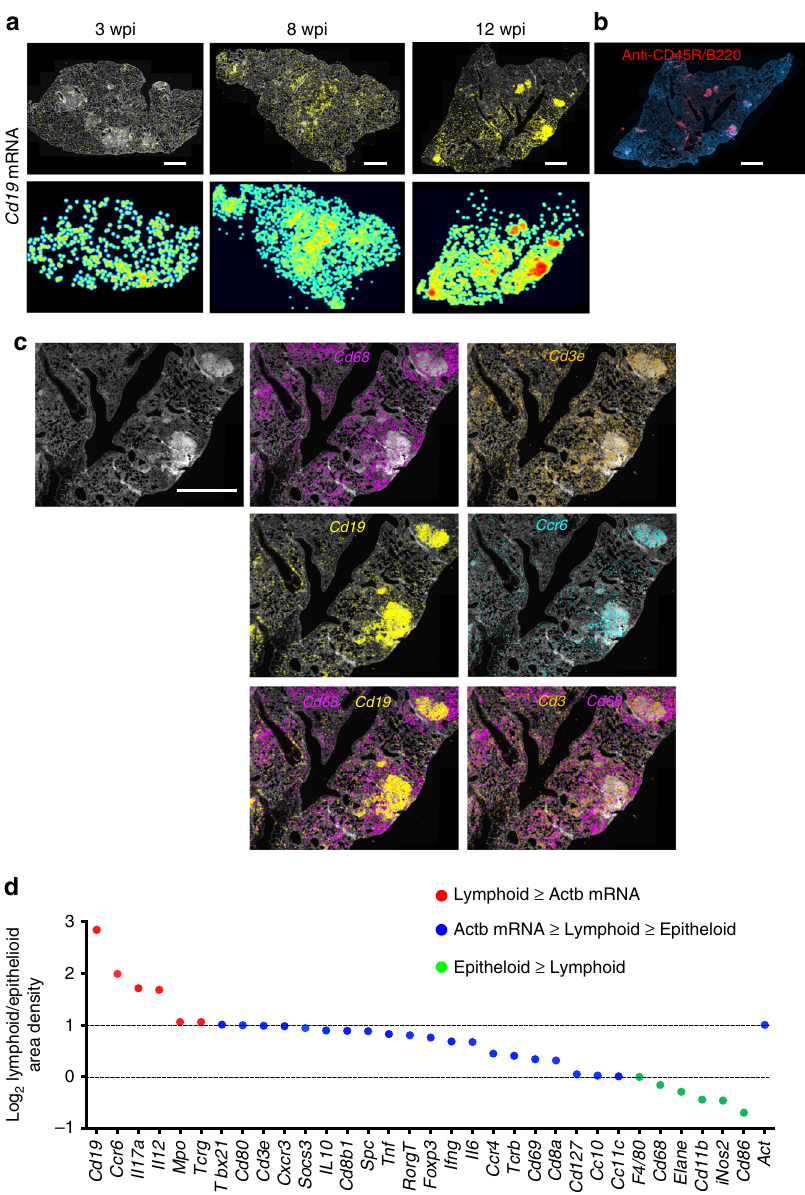
Fig. 3 Distinct localization of Cd19 mRNA within the lymphoid-rich areas in the granuloma. a In situ detection of Cd19 mRNA transcripts in lungs from M. tuberculosis -infected animals. For one representative of three consecutive sections per time point, the DAPI staining, Cd19 mRNA raw signals, and pseudo- color log 2 density plots are shown. Scale: 1000 μ m. b Immunohistochemical labeling of CD45R/B220. Note the similar pattern of the labeling as compared with the in situ staining for Cd19 mRNA in a consecutive section at 12 wpi in a . Scale bar: 1000 μ m. c The expression of Cd68 , Cd3e , Cd19 , and Ccr6 mRNA in one representative granuloma from C57BL/6-infected mice at 12 wpi is shown. Cd68 and Cd19 sequences locate in distinct areas of the granuloma, whereas Cd3e mRNA locates in both Cd68 and Cd19 mRNA-rich areas. Scale bar: 1000 μ m. d The density of sequences in the epithelioid or lymphoid areas as de fi ned in Supplementary Fig. 1 were quanti fi ed in three consecutive sections at 12 wpi. The ratios of sequence densities in lymphoid/epithelioid areas were calculated per section and the mean is depicted. The ratios were color coded accordingly if their relative frequency was higher (red) to Actb mRNA or if lower than the frequencies in epithelioid cells (green). Transcripts with ratios of lymphoid/epithelioid >1 and less than the ratio of Actb mRNA are depicted in blue. Source data are provided as a Source Data fi